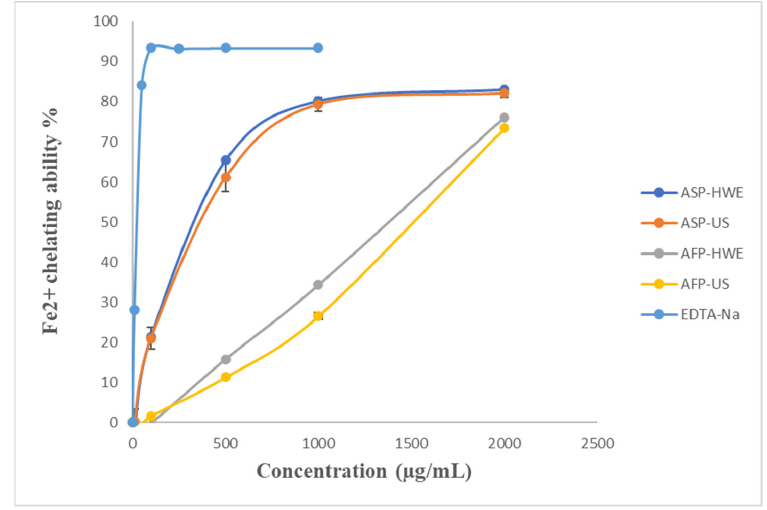
14 of 19 Figure 4. The ABTS scavenging ability of polysaccharides extracted from Ajwa seed and flesh. Re- sults are presented as means ± standard deviations ( n = 3). Differences are statistically significant if p < 0.05 when compared to the control. 3.6.2. Fe Chelating Ability The Fenton free radical reaction, which is triggered by ferrous ions, can produce re- active oxygen species and cause oxidative damage to cells. Accordingly, the chelating ef- fect on ferrous ions has recently become a popular method for evaluating part of the anti- oxidant activity of polysaccharides. The capacity of polysaccharides to chelate iron may be due to the development of cross-bridges between the uronic acid carboxyl group and the divalent ions [66,67]. The chelating capacity of Ajwa polysaccharides increased with concentration, as expected (Figure 5). The Fe 2+ chelating activities at 2 mg/mL of the four polysaccharides ASP-HWE, ASP-US, AFP-HWE, and AFP-US were 83.06% ± 3.32%, 82.11% ± 1.04%, 76.13% ± 0.76%, and 73.42% ± 1.21%, respectively. The control EDTA-Na 2 demonstrated the highest antioxidant effect with 93.39% ± 0.10% capacity to chelate fer- rous at 100 μ g/mL. With the different radical scavenging experiments, Ajwa polysaccha-